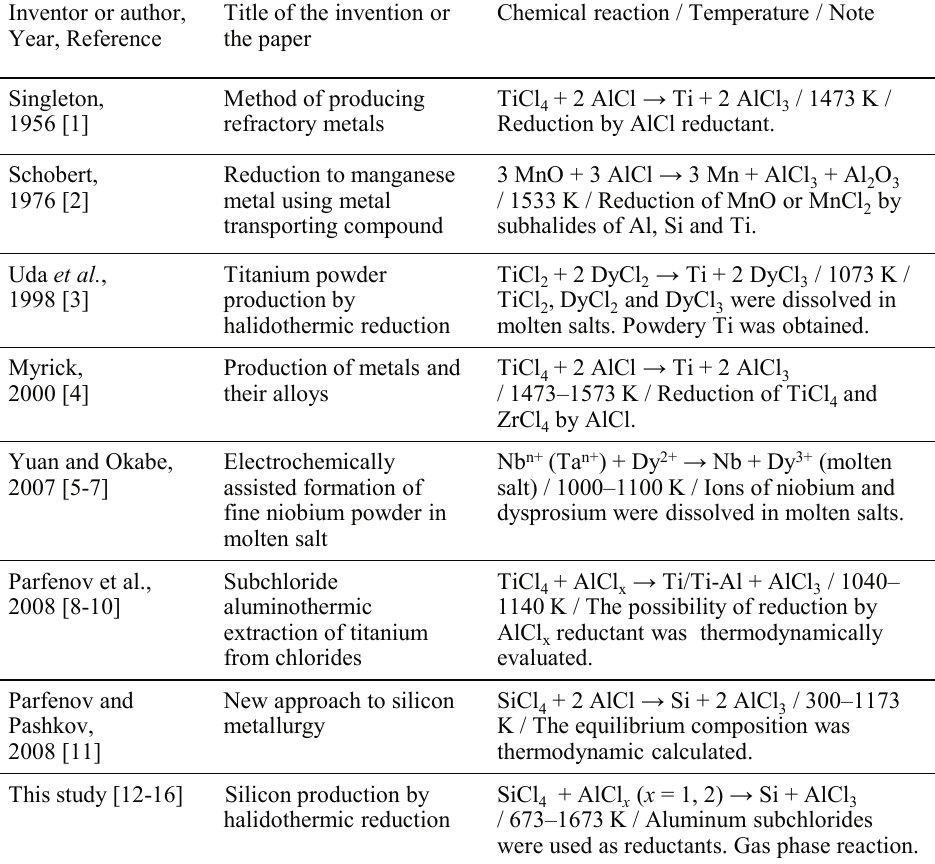
Table 1. Metal production processes based on subhalide reduction investigated or developed in the